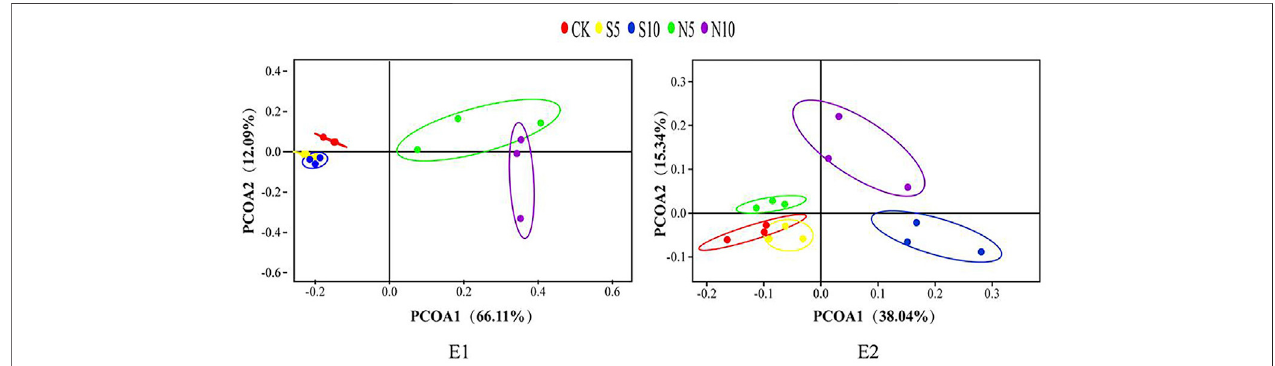
FIGURE 1 | Principal component analysis (PCA) of bacterial communities of stylo silage mixed with stylo meal and N. cadamba leaf meal (E1 and E2, experiments 1 and 2; CK, control; S5 and S10, mixed with 5% and 10% stylo meal; N5 and N10, mixed with 5% and 10% N. cadamba leaf meal).